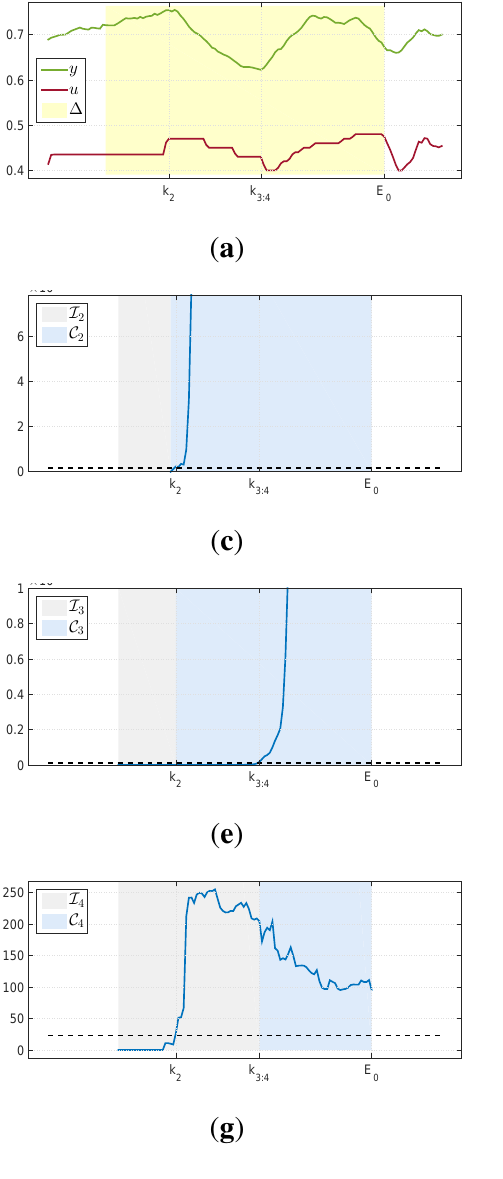
Figure 3. Examples of retrieved intervals and the quantities used during the algorithm